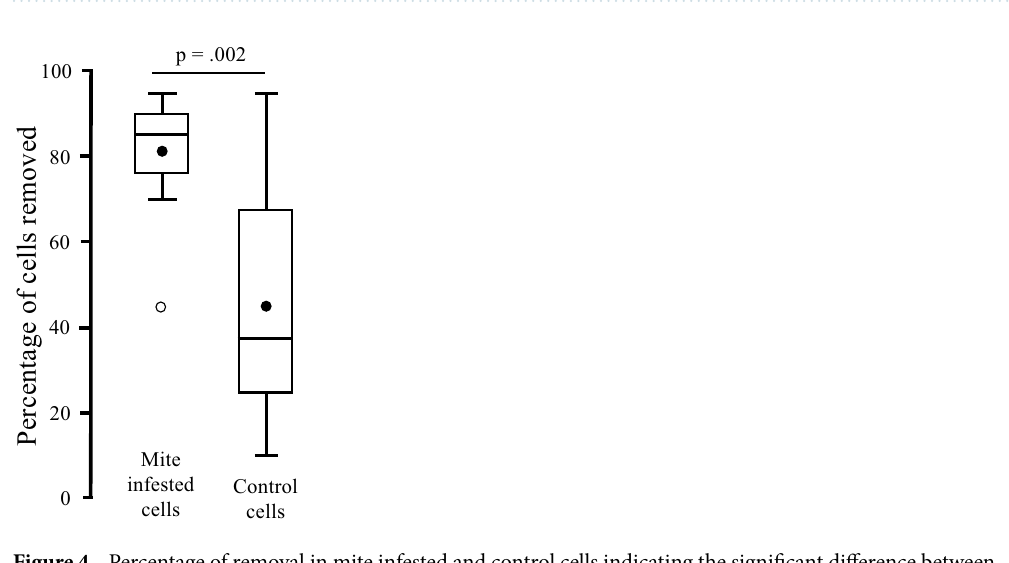
Figure 3. Size of recapping holes in Varroa-naïve worker cells (Kauai) compared with Cuban workers and drones capped brood that were infested or not.